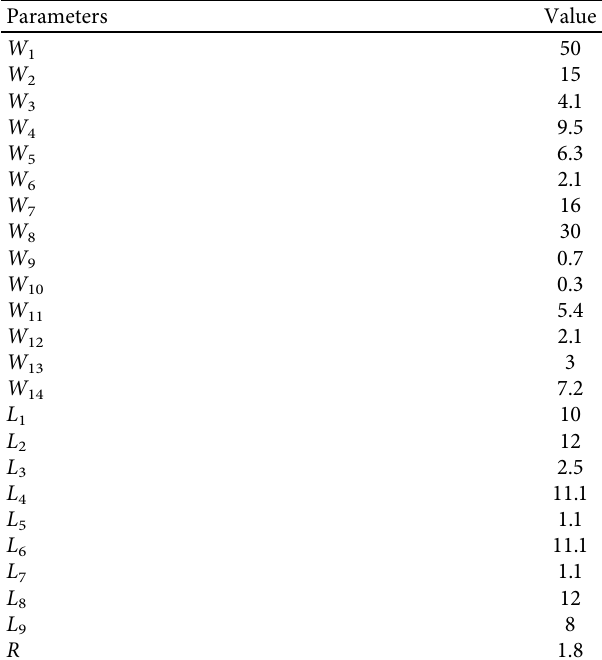
Figure 5: The isolation performance of the MIMO antenna with and without rectangular stub. Table 1: Dimensions of the proposed antenna (unit: